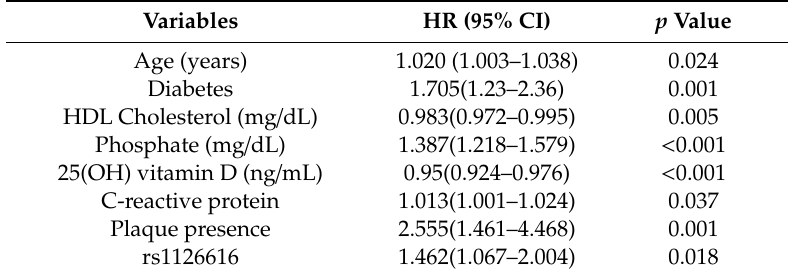
Table 4. Cox regression modelling the incidence of CVE including dialysis patients ( n = 2093). Variables